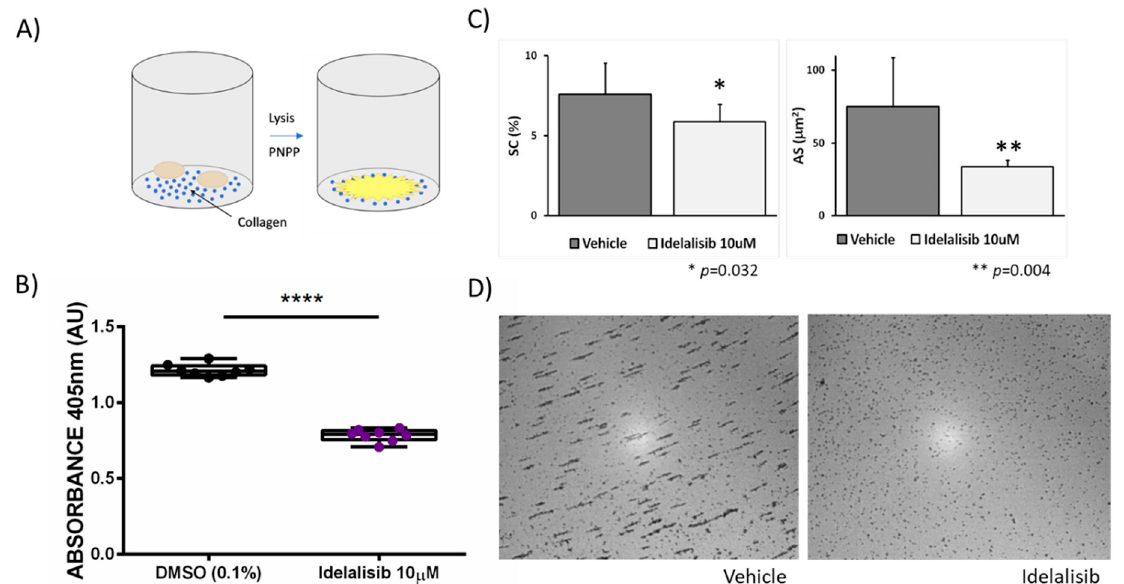
Figure 3. Idelalisib significantly inhibits platelet adhesion to collagen and impairs platelet adhesion and aggregation in the Impact-R test. ( A ) Schematic representation of the adhesion assay. For further information please see the Methods section. ( B ) Inhibition effect of Idelalisib on platelet adhesion to collagen. **** p < 0.0001. ( C ) Impact-R test: Plots show the mean values plus standard deviation of the plate surface covered by adhered platelets (%SC) and the average size of the platelet aggregates (AS μ m 2 ), obtained in blood samples under shear stress, assayed in duplicates, from five different healthy individuals, comparing vehicle samples and samples treated with 10 μ M Idelalisib. ( D ) Representative images of the Impact ‐ R evaluation test of untreated blood (vehicle) or blood incubated with 10 μ M Idelalisib.